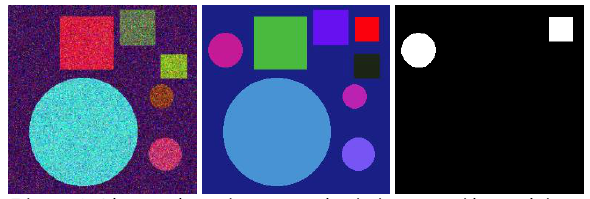
Figure 4. Change detection on synthetic images without objects shifts: left – input image A, middle – input image B, right – synthesized difference map 4.2 Experiments on the synthetic image dataset with object shifts